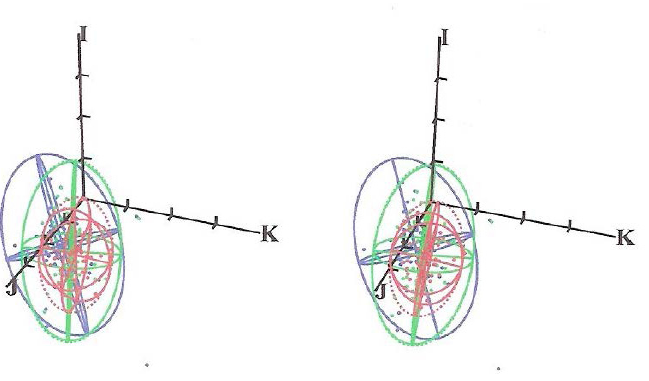
Figure 5: Stereo-pair scatter plot of fifty measurements of re- fractive state taken from subject 4. The origin of the axes is at 0.5 I